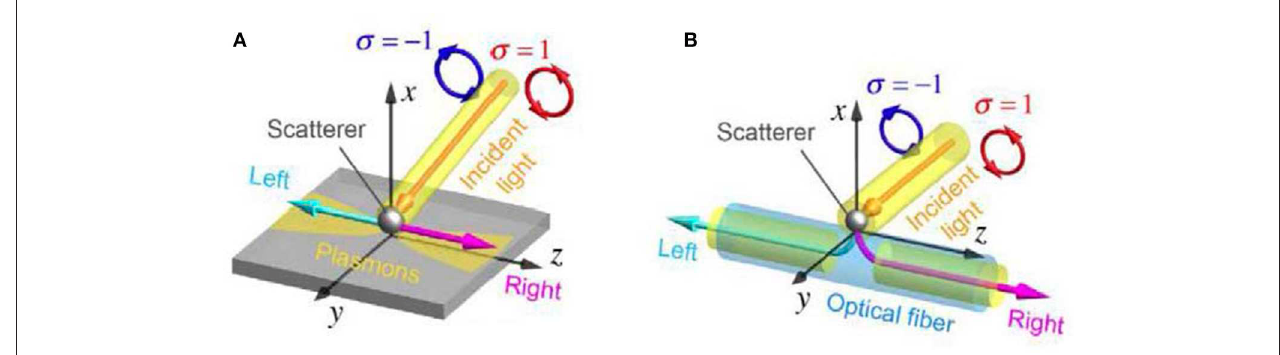
FIGURE 13 | Spin-controlled unidirectional coupling of light to oppositely propagating modes: (A) in the planar geometry; (B) excitation of an optical-fiber-guided mode (the figure is adapted from the presentation by K. Bliokh, ©